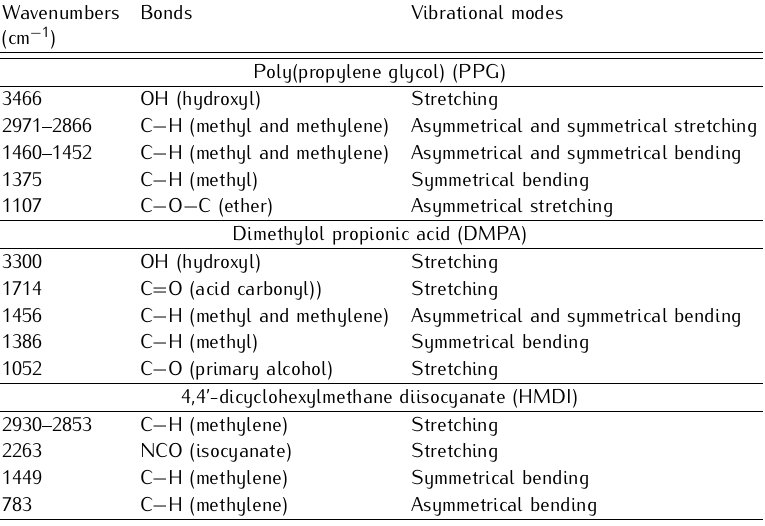
Table 1. Characteristic group absorptions present in FTIR spectra of the monomers (PPG, DMPA and HMDI) [8, 19–25, 28].